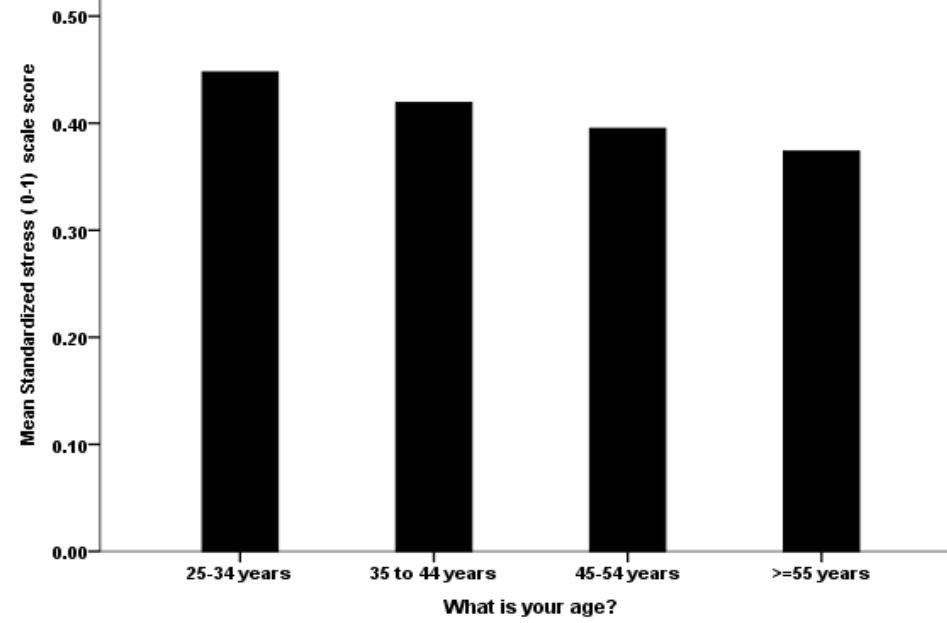
Figure 3. The association between the HCW’s age group with their mean perceived standardized stress score.